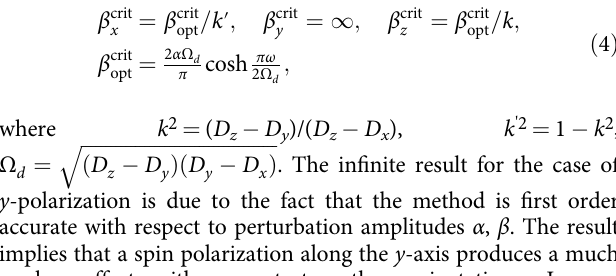
of lobes: the escaping ones (marked by red color), which tend to bring points outside the well, and the capturing lobes (marked by blue color), which tend to bring points inside the well. Escaping